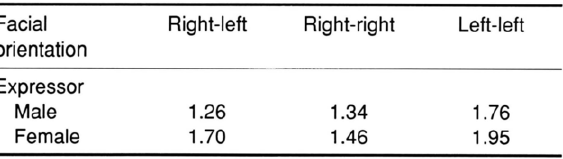
TABLE I. Mean rating for the emotional valence.' The values of pleasantness and unpleasantness are taken together to obtain